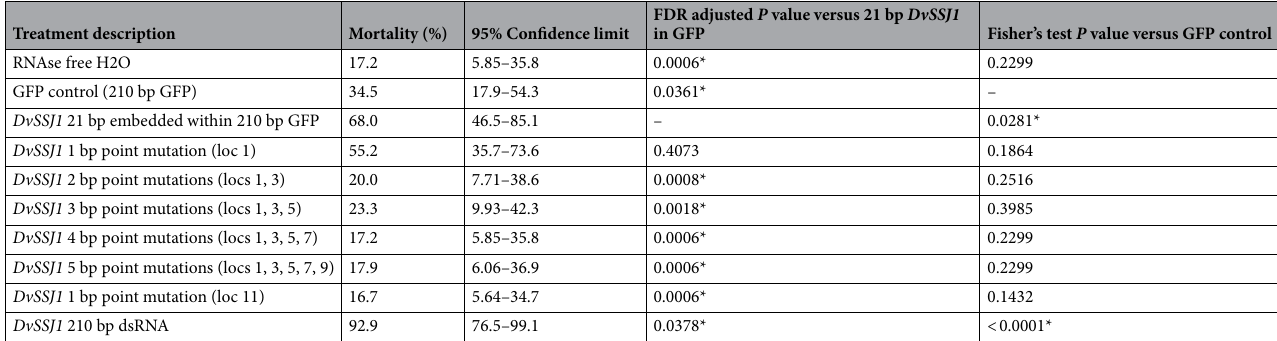
Table 3. Analysis of WCR mortality for dsRNA specificity data. Increasing single nucleotide polymorphisms (SNPs) were introduced in various locations (loc) within the DvSSJ1 21-mer and fed to WCR over 14 days to assess WCR mortality. *A statistically significant difference ( P value < 0.05) was observed.